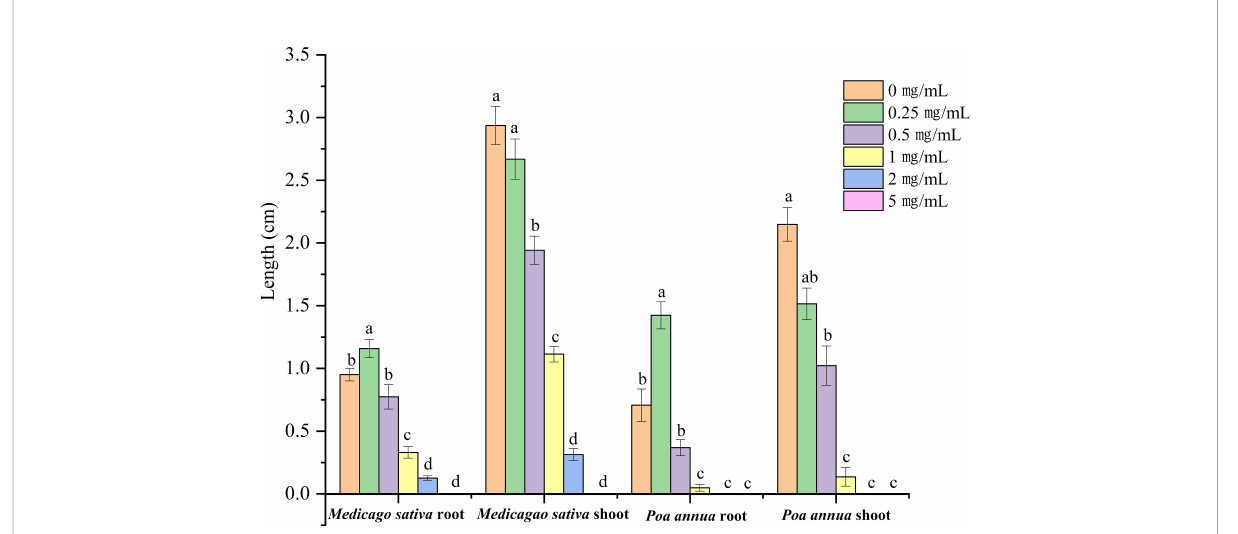
FIGURE 1 Phytotoxic effects of A. tibetica EO on seedling growth of P. annua and M. sativa (n = 60). Different letters represent a signi fi cant difference at P < 0.05 level according to Fisher ’ s LSD